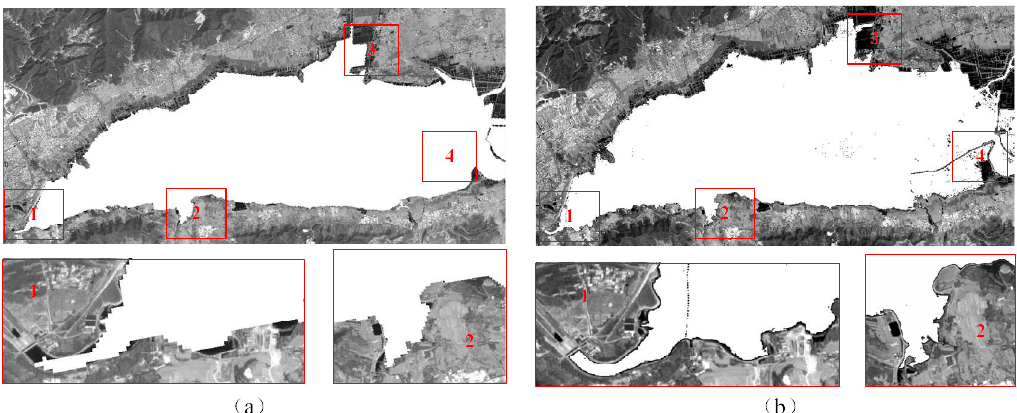
Figure 8. The comparison of the water masks and the ROIs for image pair block 1. ( a ) FROM-GLC10 water masks. ( b ) ROIs.